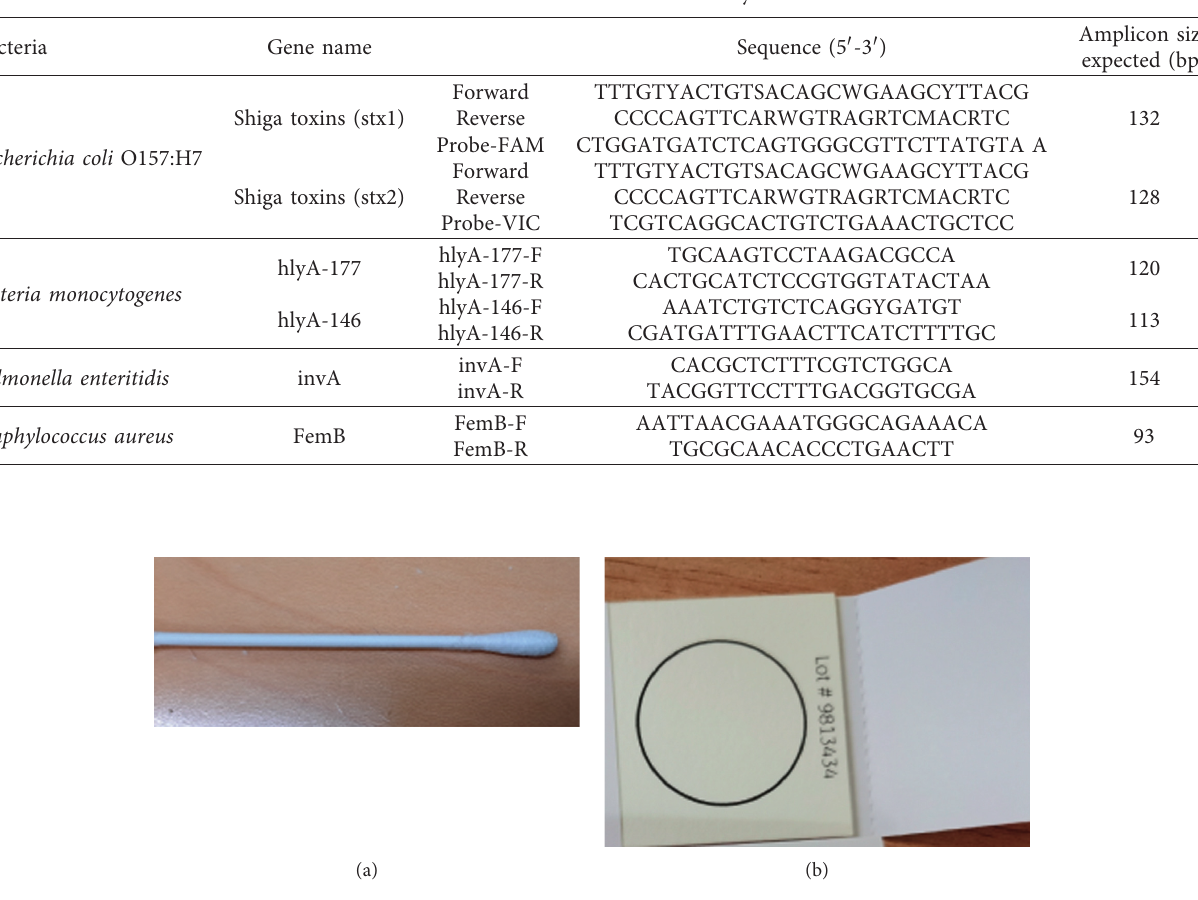
Figure 1: Conventional swab and Whatman FTA card.